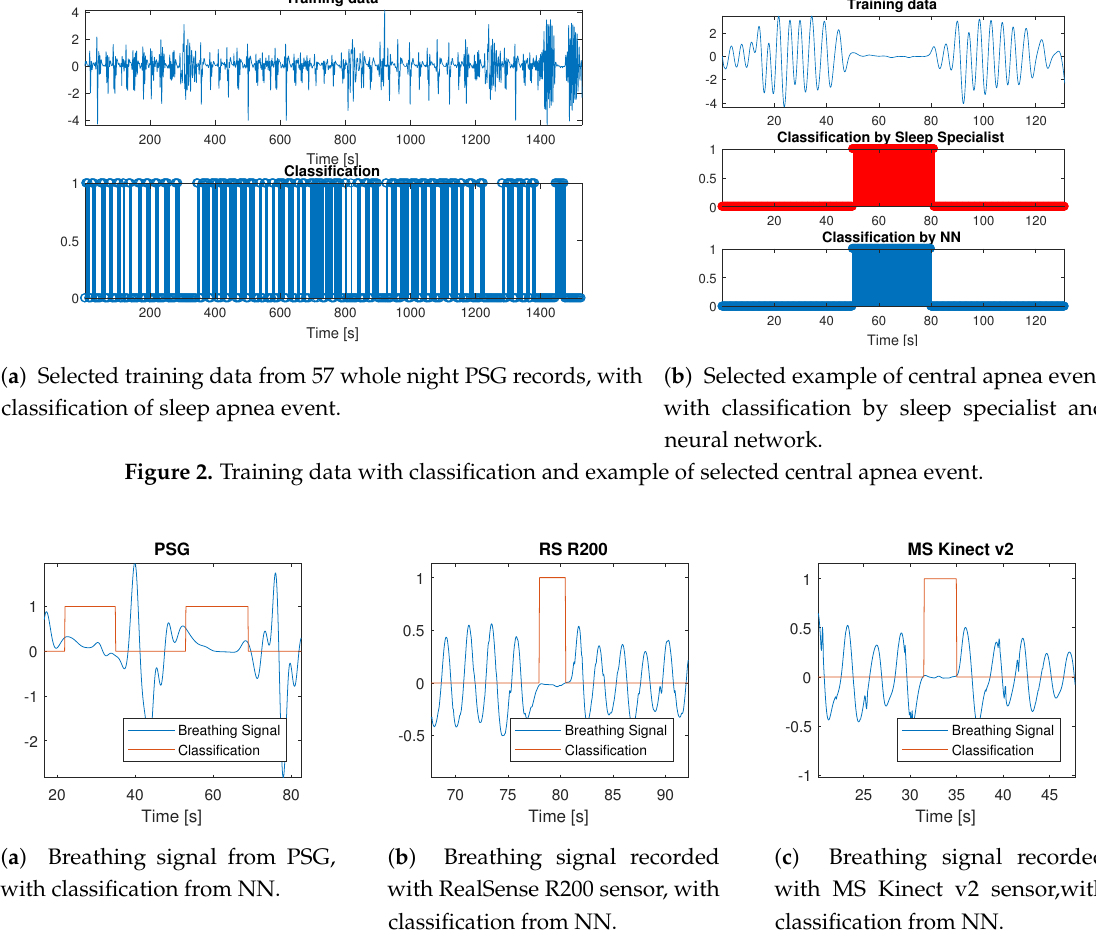
Figure 3. Comparison of sleep apnea classification. All signals are with a sampling frequency of 10